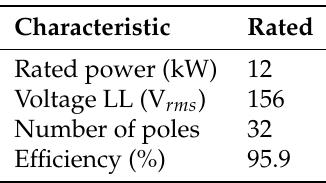
Table 4. Generator parameters for the 12 kW